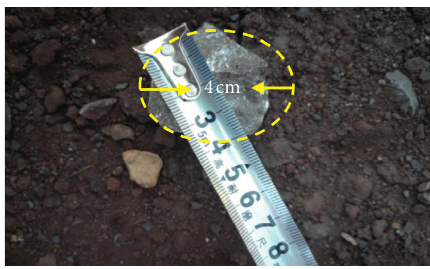
Figure 5: The size of rockfall in K503 +585 ∼ 504 +018